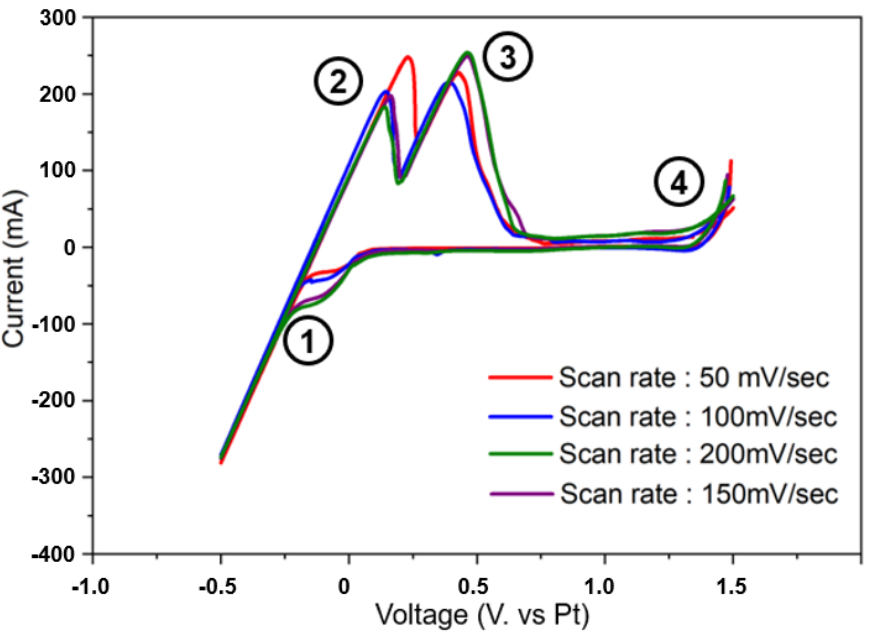
Figure 2. Cyclic voltammetry analysis results for cell potential measurement according to redox reaction behavior analysis of electrolyte ions of constructed electrodes.